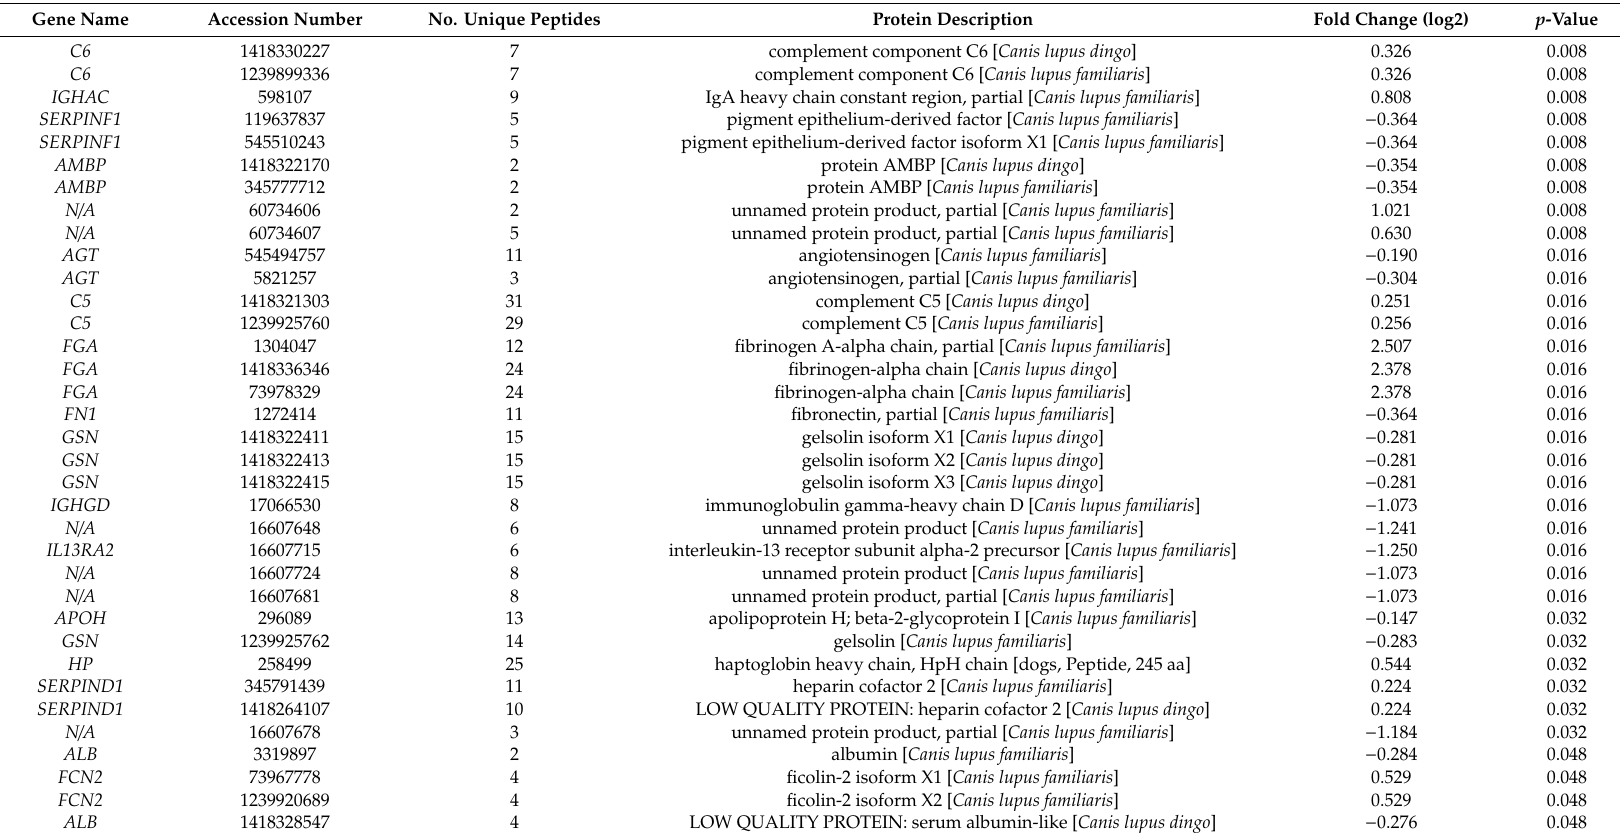
Table A1. Serum proteins identified in dogs with canine mammary tumors (CMT) and healthy controls